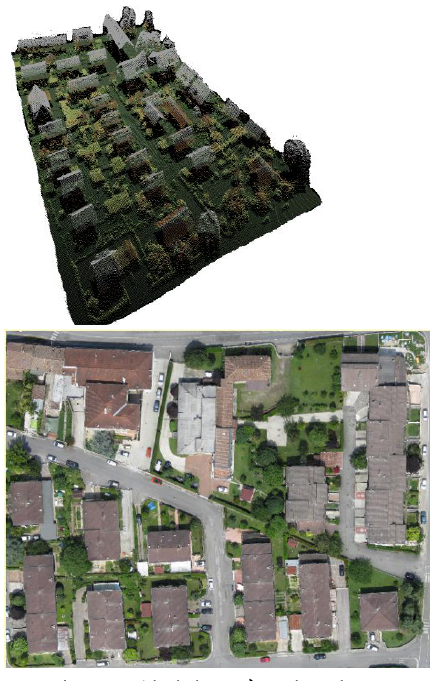
Figure 4. The provided data a) Ortho Photo area B) produced